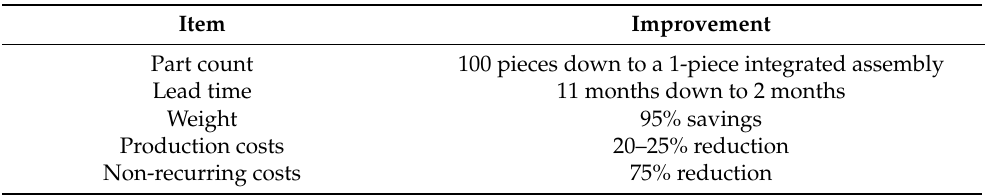
Table 1. Profitability analysis of the effects of AM-enabled part consolidation of a high-bandwidth, direction tracking antenna array carried out by Optisys LLC [13].